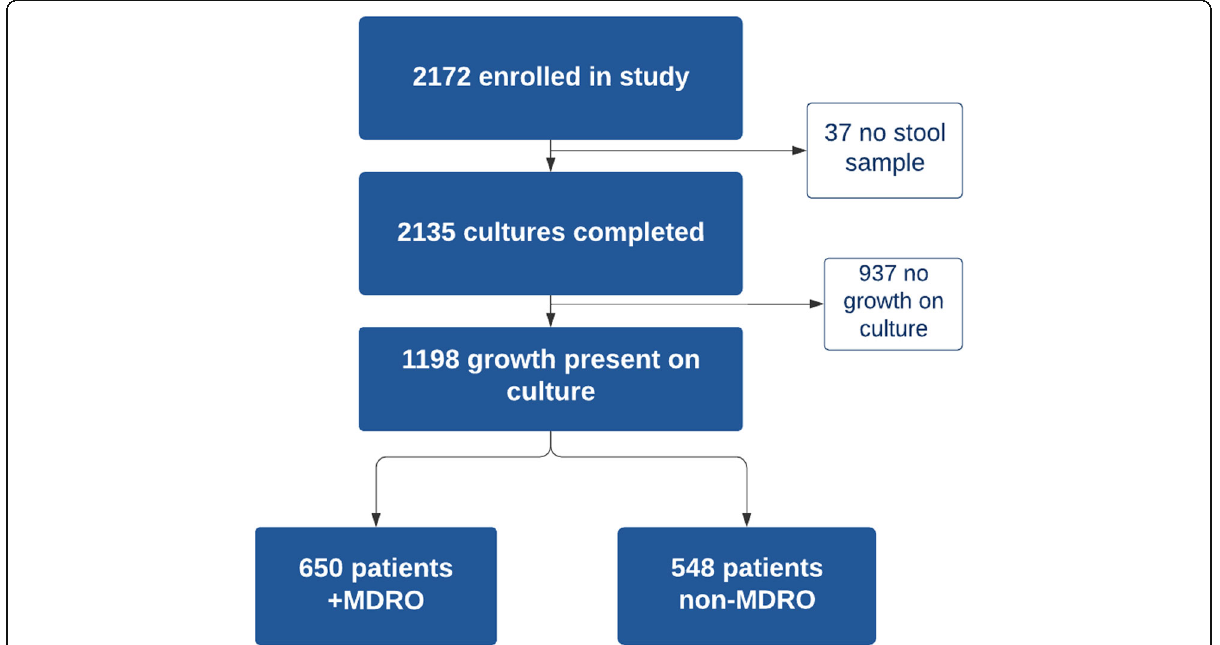
Fig. 1 Flowchart of included study